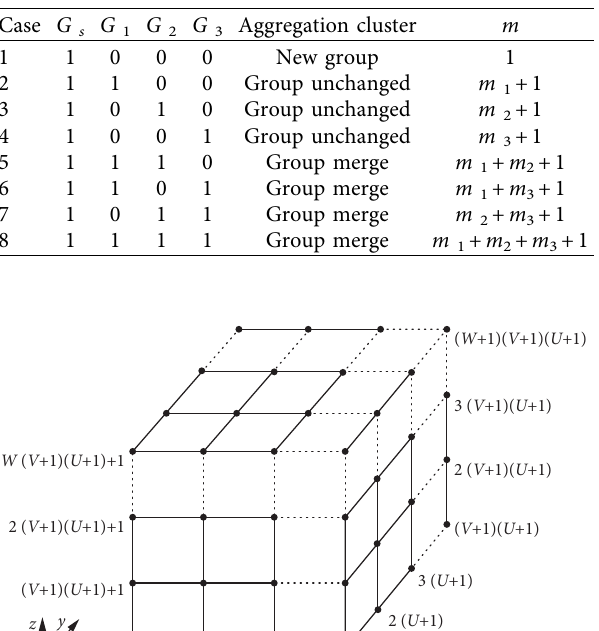
Table 1: Cluster integration.